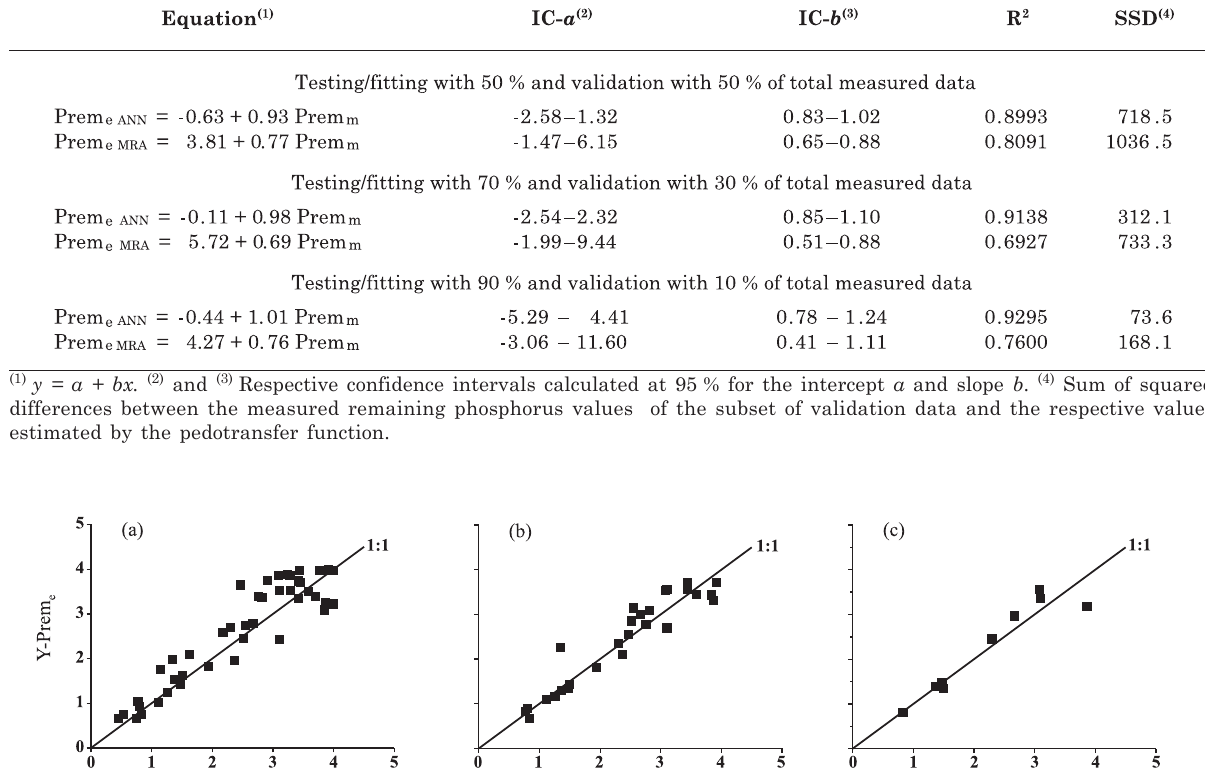
) estimated by artificial e